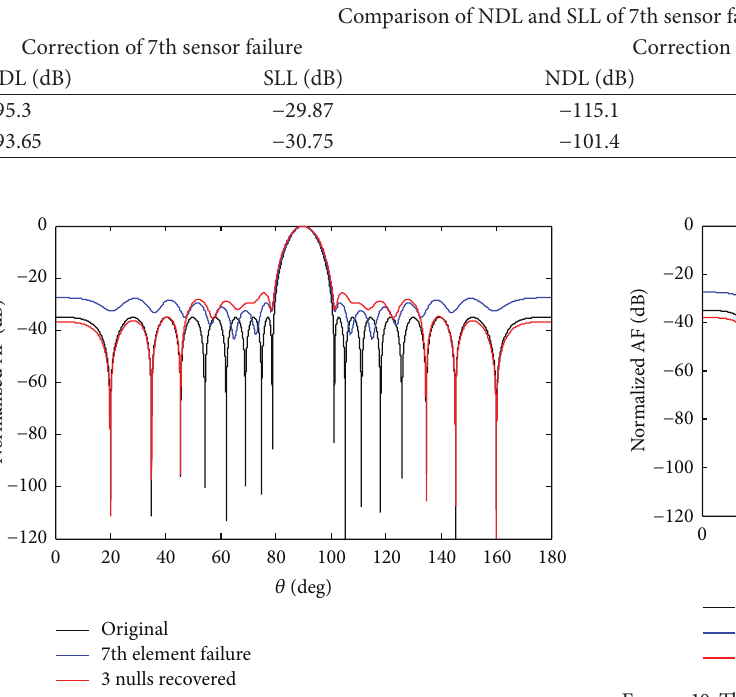
Figure 8: The original radiation pattern, the 𝑤 7 sensor damage, and recovery of three nulls.